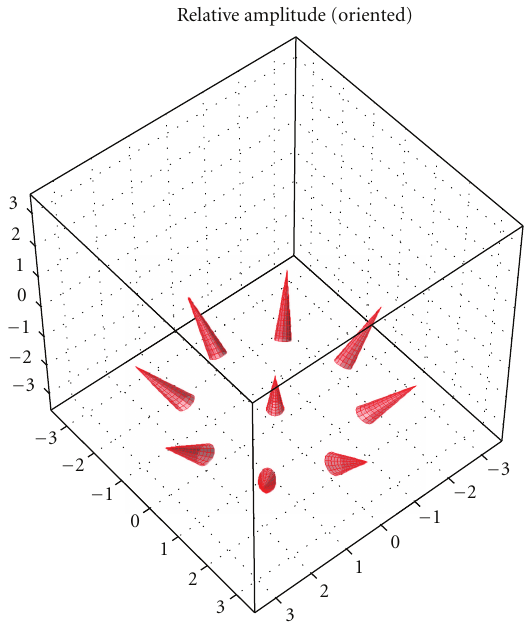
Figure 7: Array elements oriented along each local Z n axis.